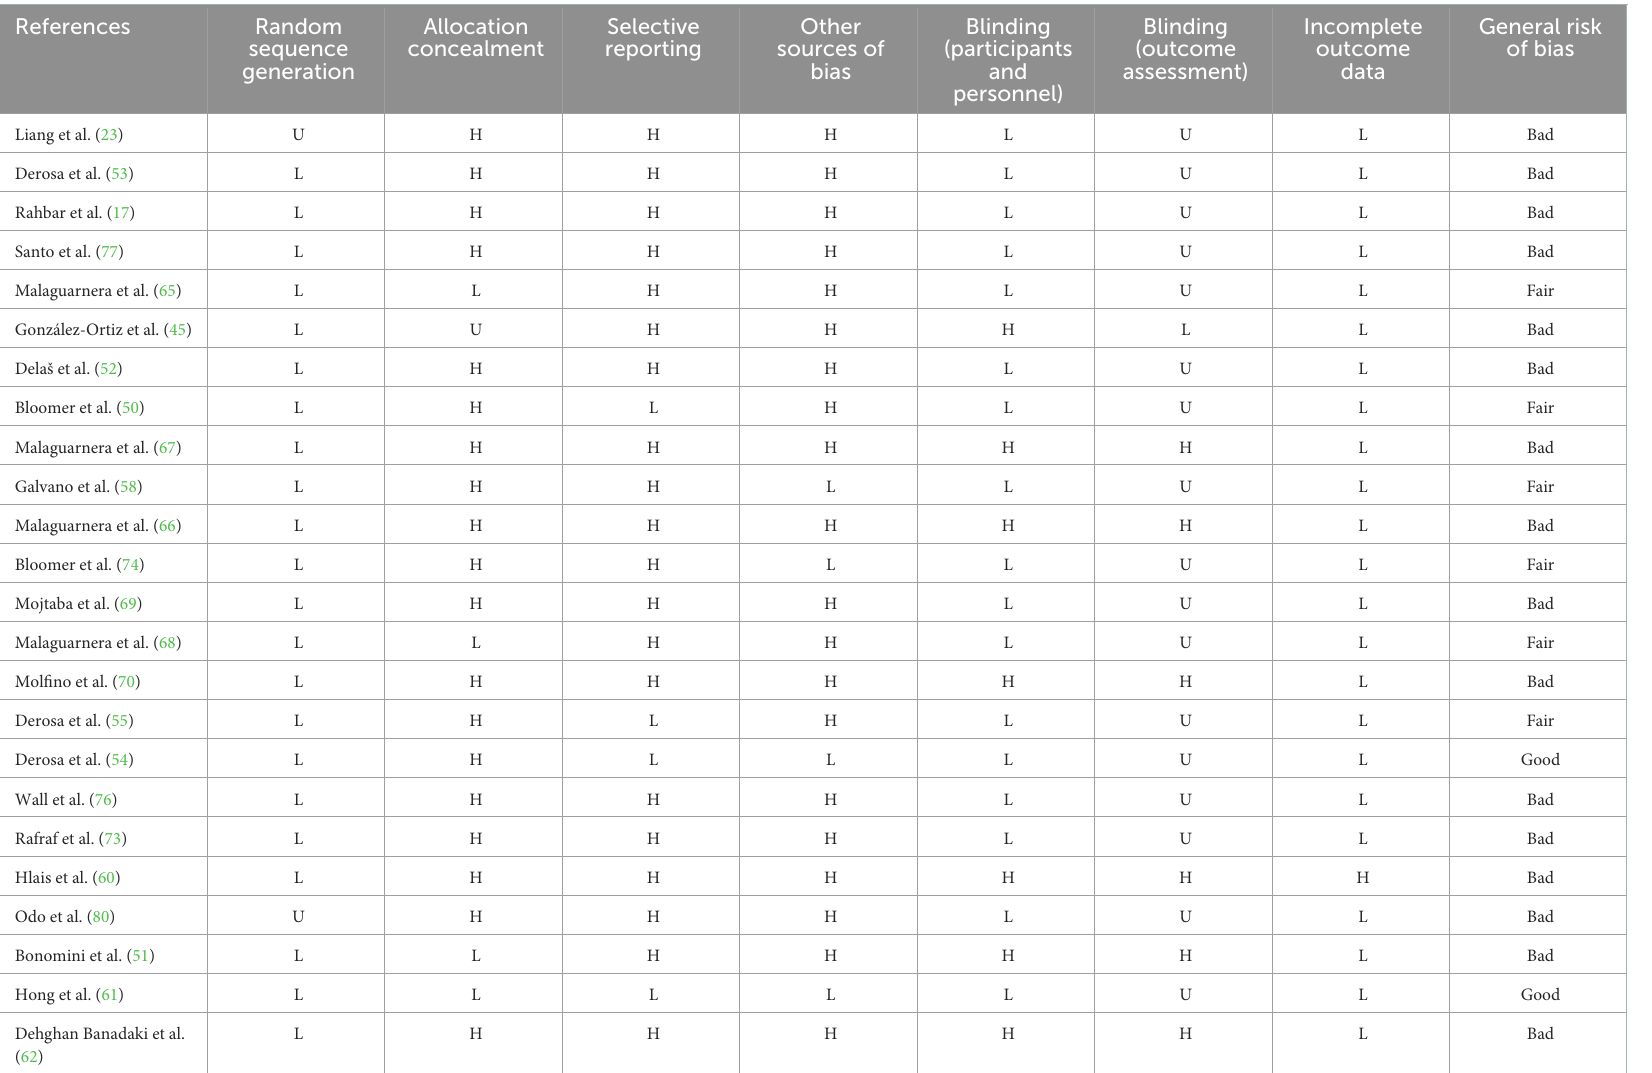
TABLE 2 Risk of bias